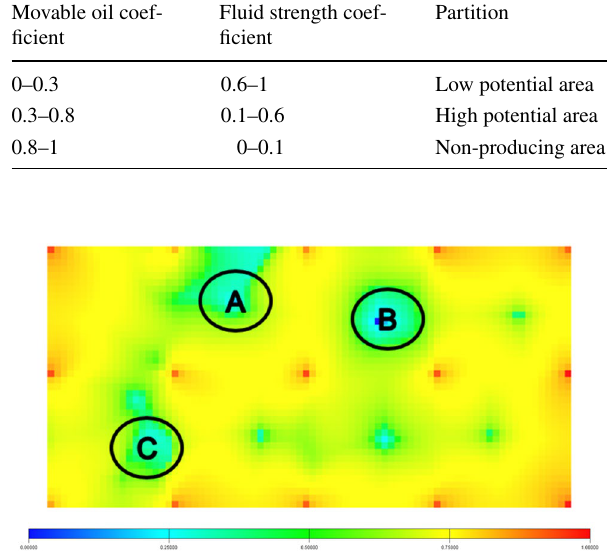
Table 2 Evaluation of fluid intensity areas Movable oil coef- ficient